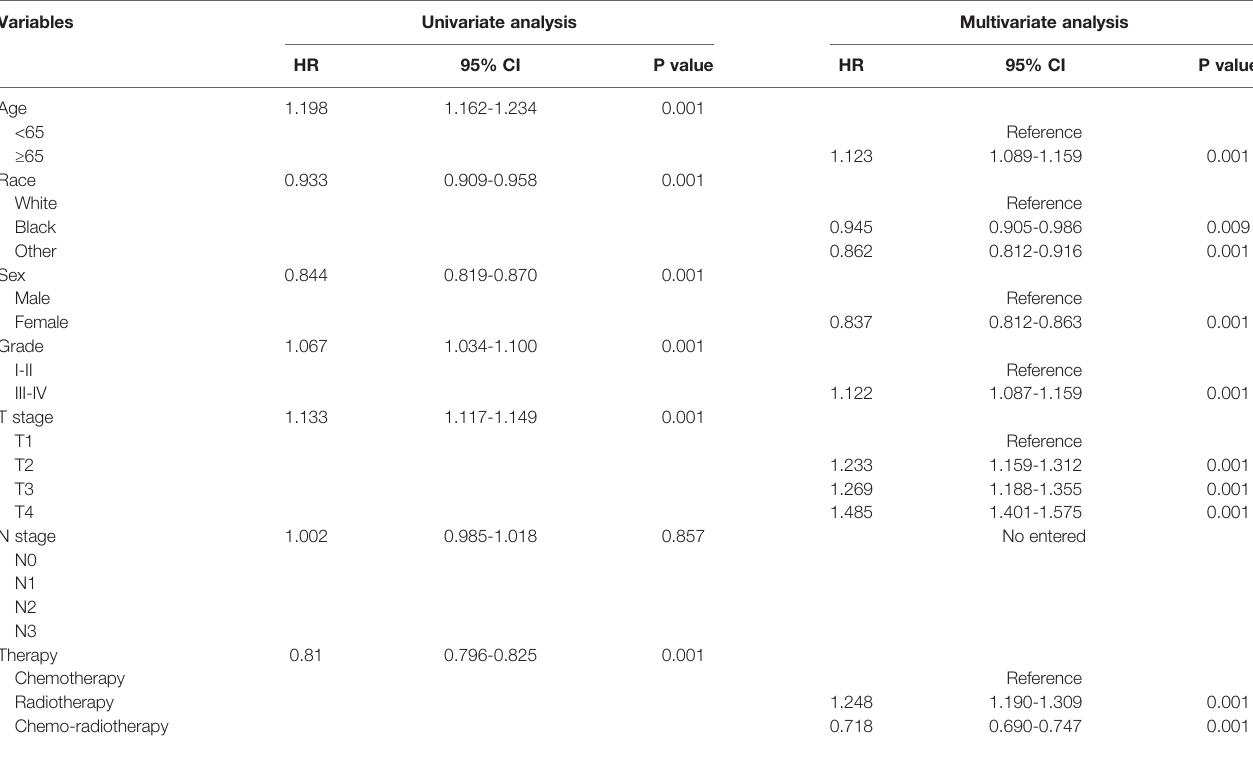
TABLE 3 | Univariate and multivariate analysis for OS.